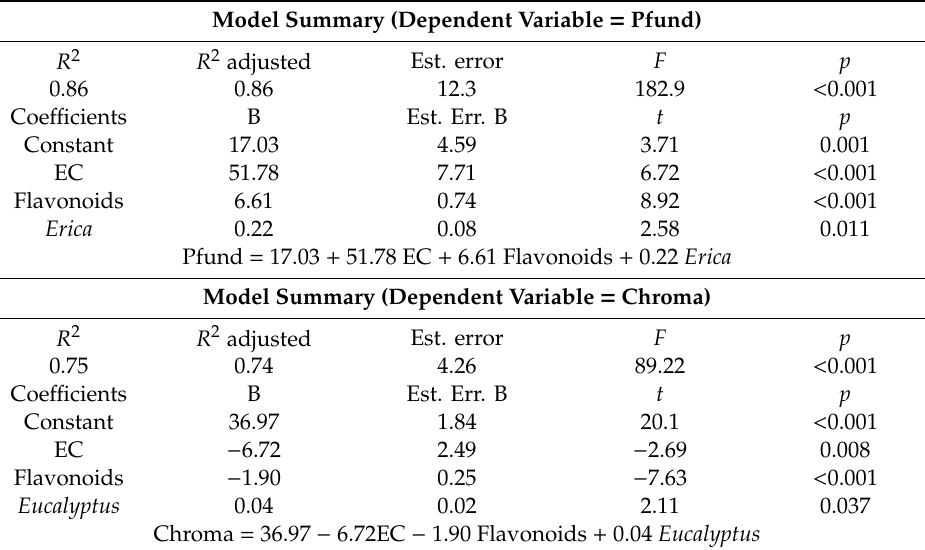
Table 4. Multiple linear regression analysis for the color parameters.